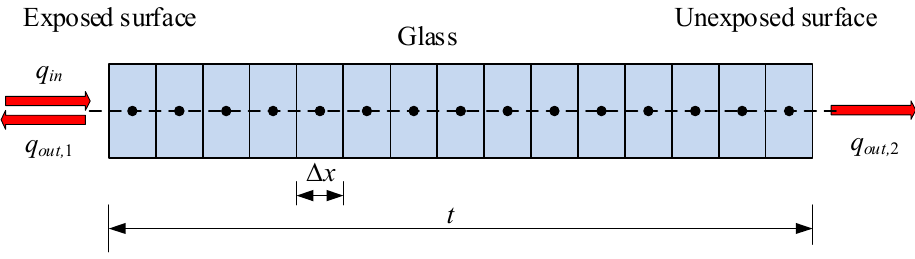
Figure 11. Illustration of the 1D heat transfer model.